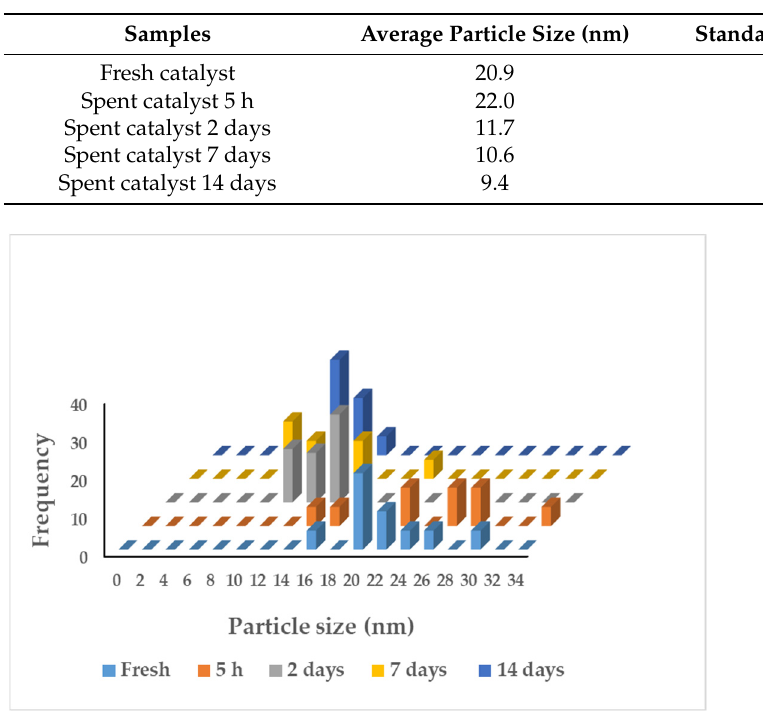
Figure 4. Particle size distribution of fresh and spent catalysts.